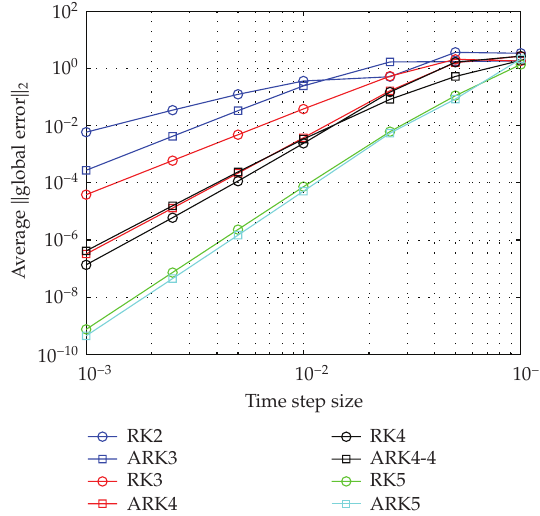
Figure 5: Accuracy plot for IVP-4 (cid:4) see caption of Figure 2 (cid:5)